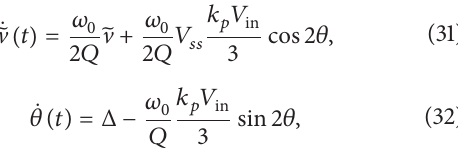
Figure 5: Phase portrait of system (18) in case of saturation-like /3 = 0.6 and 𝑄Δ/𝜔 = 0.68 . The black dot nonlinearity for 𝑘𝑉 0 in denotes a stable steady-state constant solution (locking), while the thick line denotes a stable steady-state periodic solution